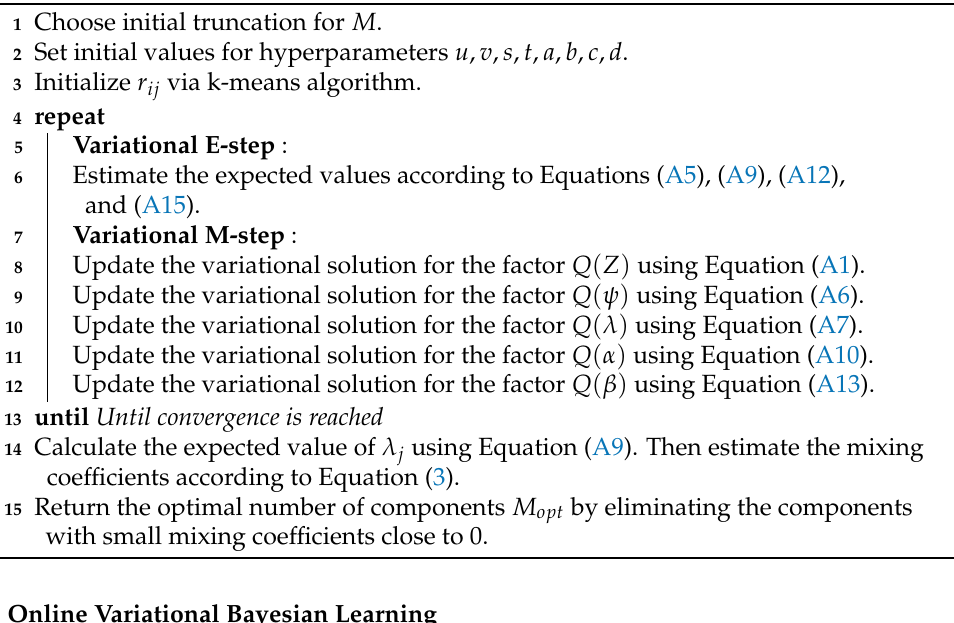
Figure 2. Graphical model of the developed variational infinite inGaMM. Random variables are denoted by circles and hyperparameters are represented by rounded boxes . Y is observed variable, Z is latent variable, large boxes are used for repeated process and the arrows show the conditional dependence between variables. Algorithm 1: Batch variational learning approach for the